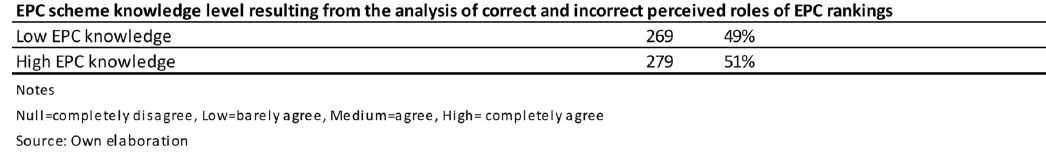
Table 4. Realtors’ knowledge of the attributes affecting EPC ratings.